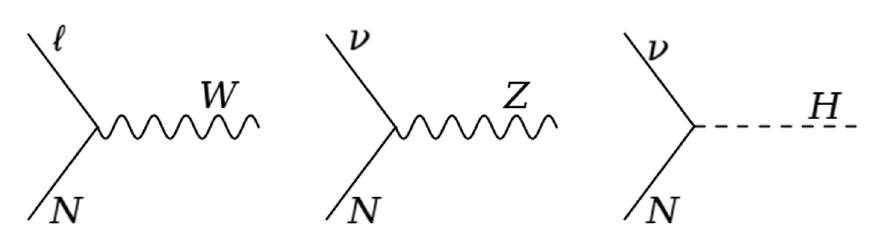
Figure 1. Extra vertices in the HeavyN model: interactions of heavy neutrinos with W , Z or Higgs